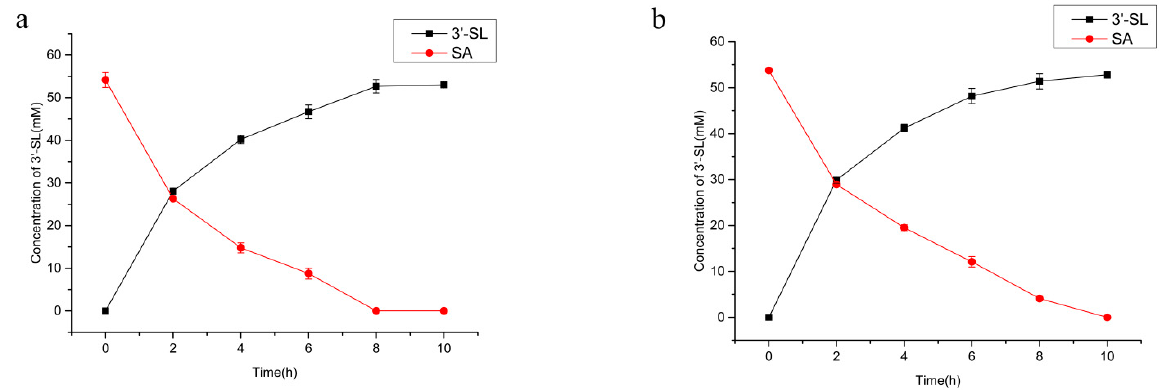
Figure 6. Time course of 3 ′ -SL production under optimal conditions. ( a ) Time course of 3 ′ -SL production in 25 mL transformation system; ( b ) time course of 3 ′ -SL production in 4 L transformation system.